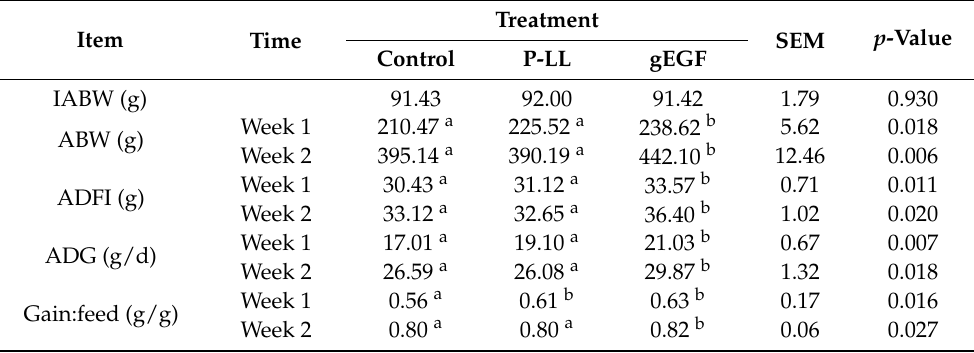
Table 2. Effects of gEGF on the growth performance and feed efficiency of broilers. SEM: Standard Error of Mean. Data represented the mean of 3 replications per treatment with 7 broilers per replication ( n = 3). Means within a row without superscripts (a or b) were of no significant difference ( p > 0.05). Means within a row with different superscripts (a or b) differed significantly ( p < 0.05). IABW: initial average body weight; ABW: average body weight; ADFI: average daily feed intake; ADG: average daily gain.